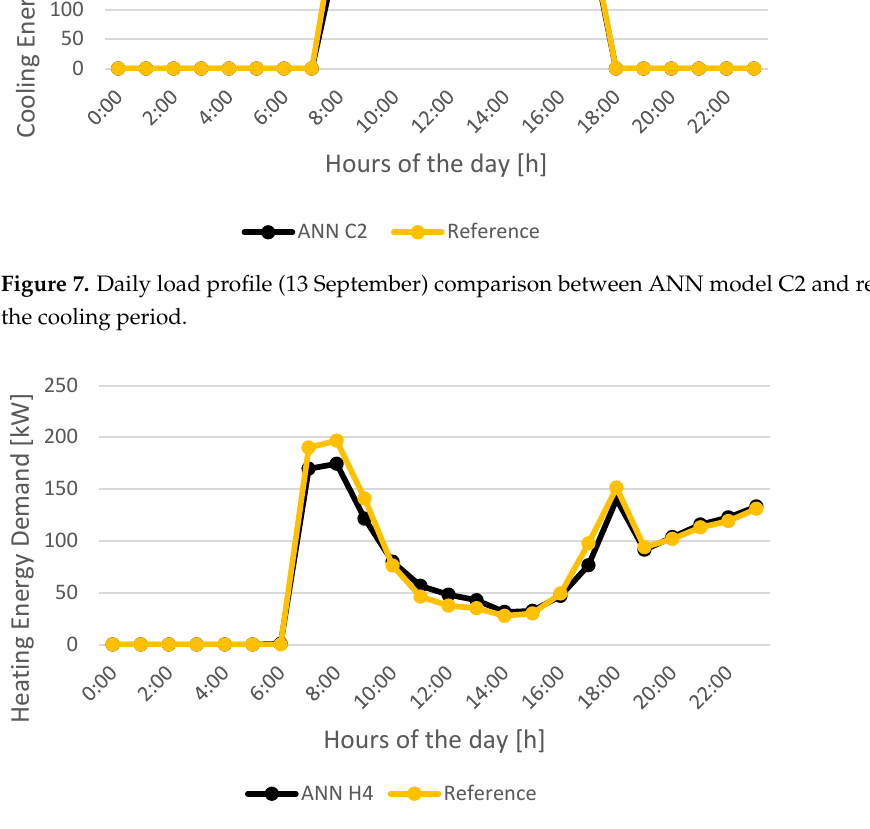
Figure 8. Daily load profile (19 December) comparison between ANN model H4 and reference for the heating period.